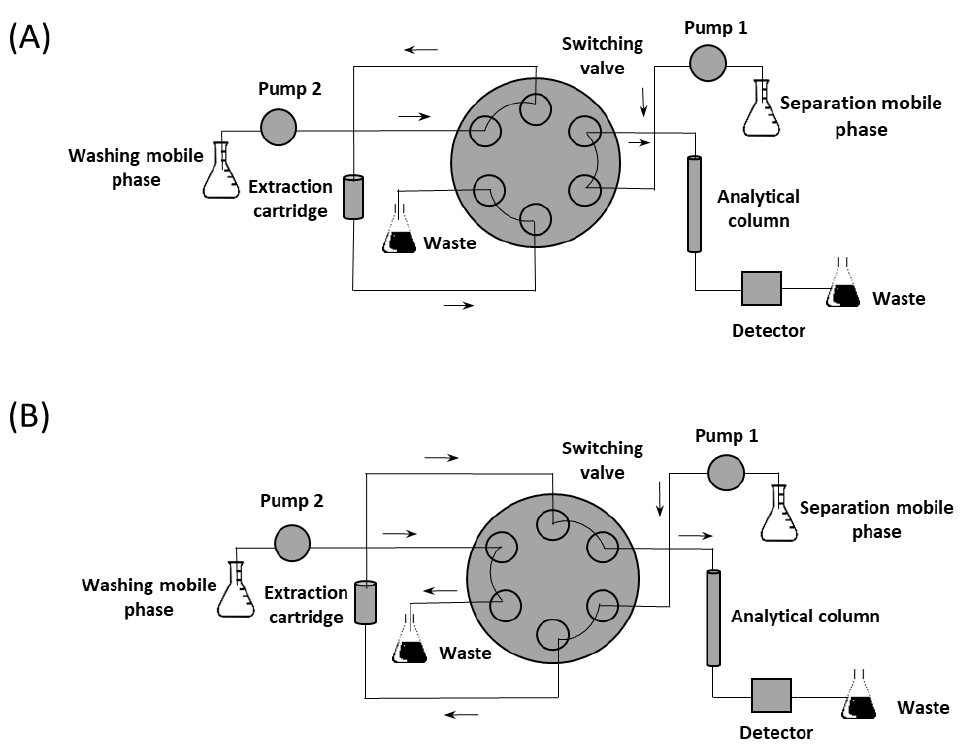
Figure 1. Column-switching chromatographic system in ( A ) on-line extraction and ( B ) on-line extraction-separation mode.